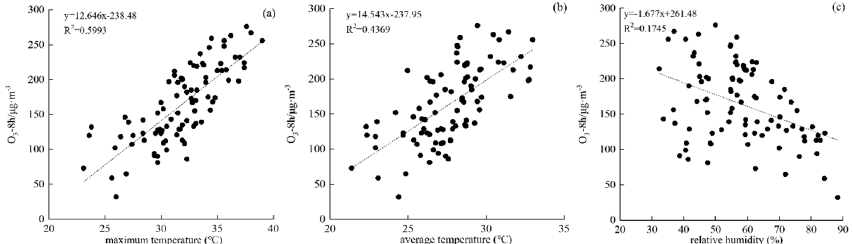
Figure 3. Correlation of O 3 -MDA8 with ( a ) maximum temperature, ( b ) average temperature, and ( c ) relative humidity.